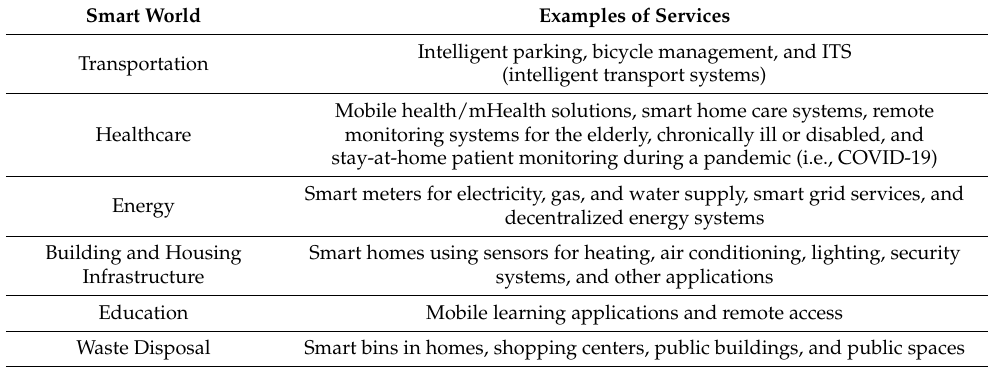
Table 1. Examples of services for 5G-enabled smart